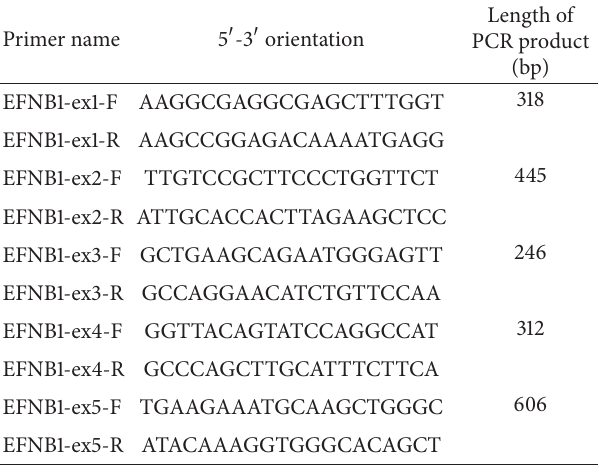
Table 1: PCR and sequencing primers for EFNB1